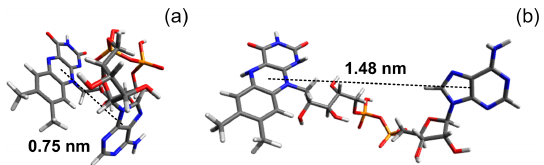
Figure 4. (a) Ground-state conformation of protonated FAD calcu- lated in the Gaussian program package (Frisch et al., 2009). (b) Ex- ample of stretched FAD conformation (PDB ID fda; Bruns and An- drew, 1995; Berman et al., 2000). Pictures were made using Avo- gadro molecule visualizer (Hanwell et al.,